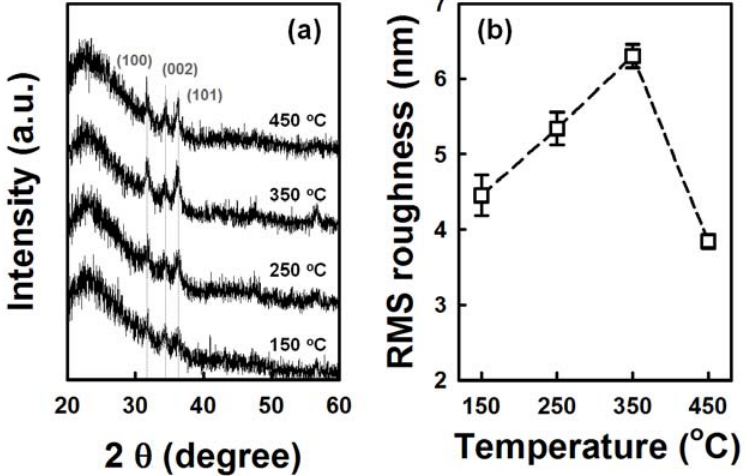
Figure 6. ( a ) XRD patterns and ( b ) root mean square (RMS) roughness of AZO seed layers with various seed layer annealing